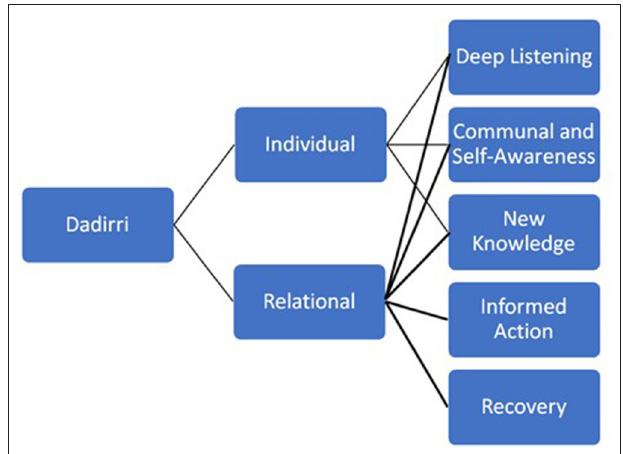
FIGURE 1 | Therapeutic phases of Dadirri as applied through individualistic and relational